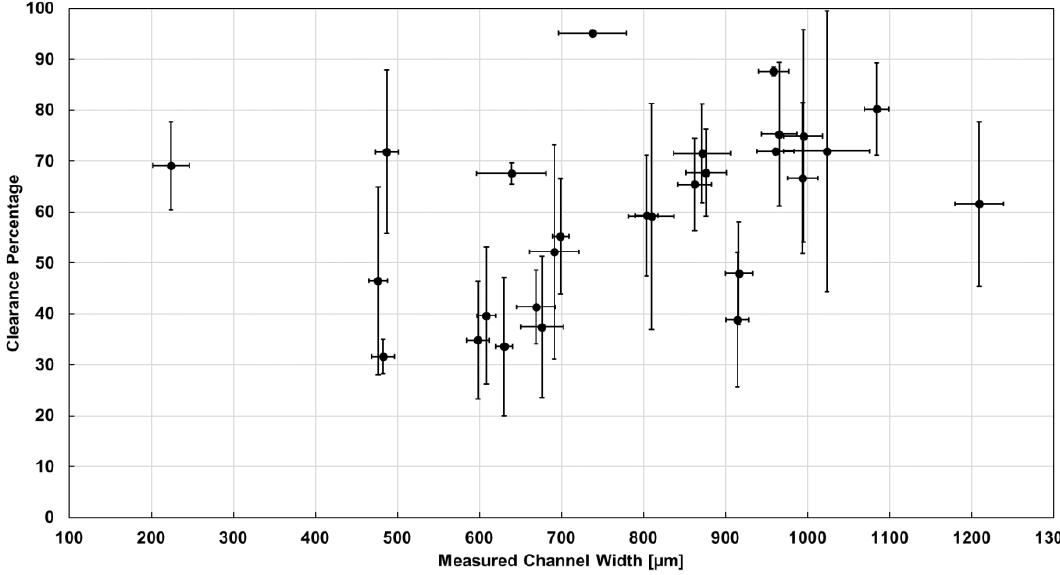
Figure 3. Channel clearance. The percentage clearance of each flow channel was estimated by optical measurements and plotted against its measured width. The results suggest that the procedure is successful and produces a significant clearance percentage over a wide dynamic range of square channel dimensions.